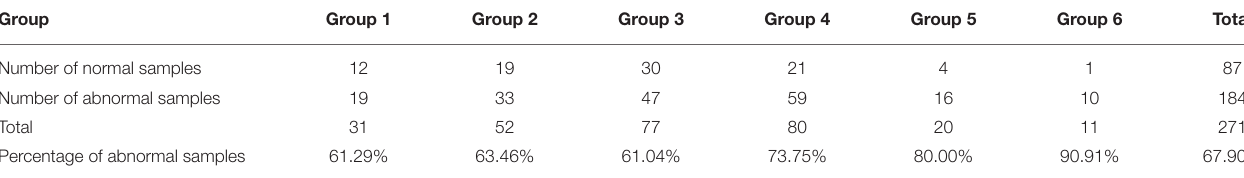
TABLE 4 | Grouping and percentage of urine samples with abnormal urine dry chemical parameters ( n = 271).